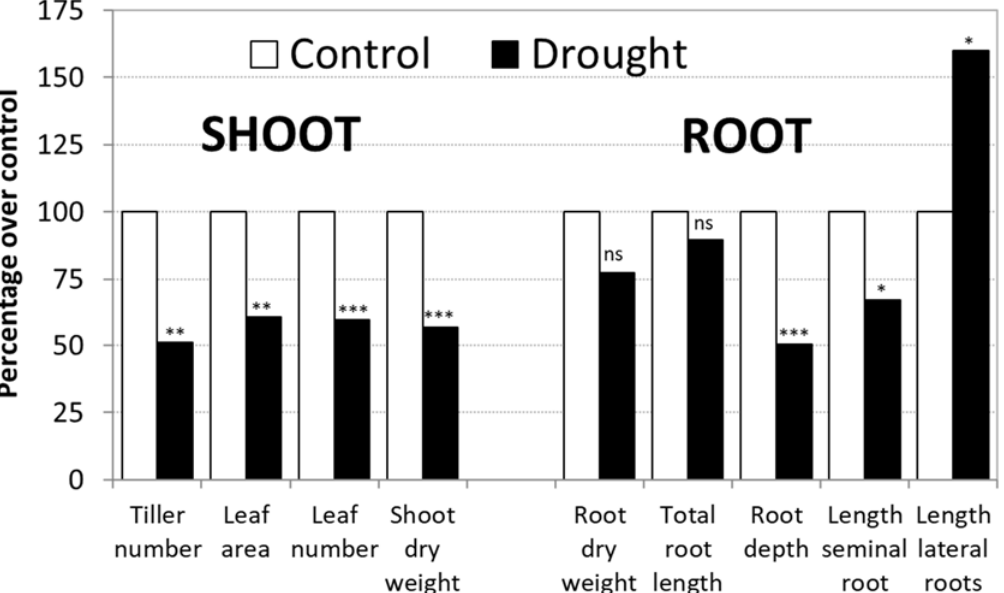
Figure 1. Averages of relative shoot and root variables for six barley genotypes grown in rhizotrons under drought, compared to the control treatment (100%). Each data point represents the average of up to twelve replicates (single plants). *, **, ***, ns, significant differences between treatments for p < 0.05, p < 0.01, p < 0.001, and non ‐ significant, respectively.